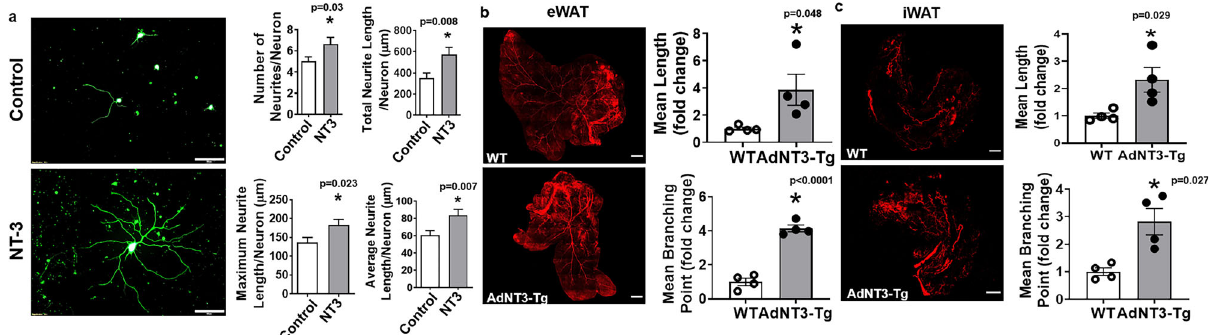
Fig. 4 NT-3 regulates sympathetic neuronal growth and innervation in adipose tissue. a Representative β III-tubulin immuno fl uorescent images of sympathetic ganglia neurons treated with NT-3 (100 ng/ml) (left panel, from three independent treatments/group, scale bar = 100 µ m) and quantitation of the number of neurites per neuron, total neurite length per neuron, maximal neurite length per neuron, and average neurite length per neurite per neuron (right panel, control n = 80, NT-3 n = 60, * indicates statistical signi fi cance between control and NT-3 treatments with unpaired two-tailed t test). Neurons from sympathetic ganglia at thoracic T1 – T4 levels from 6- to 8-week-old mice were isolated and used in the experiment. b , c Representative images of TH- positive sympathetic nerve innervation in eWAT ( b , left panel, from four replicate animals/group, scale bar = 2000 µ m) and iWAT ( c , left panel, from four replicate animals/group, scale bar = 2000 µ m) and quantitation of mean nerve fi ber length and mean nerve fi ber branching points normalized to total adipose tissue area in eWAT ( b , right panel, n = 4/group, * indicates statistical signi fi cance between WT and AdNT3-Tg with unpaired two-tailed t test) and iWAT ( c , right panel, n = 4/group, * indicates statistical signi fi cance between WT and AdNT3-Tg with unpaired two-tailed t test) in AdNT3-Tg mice and their littermate control mice after a 7-day cold challenge. All data are expressed as mean ±